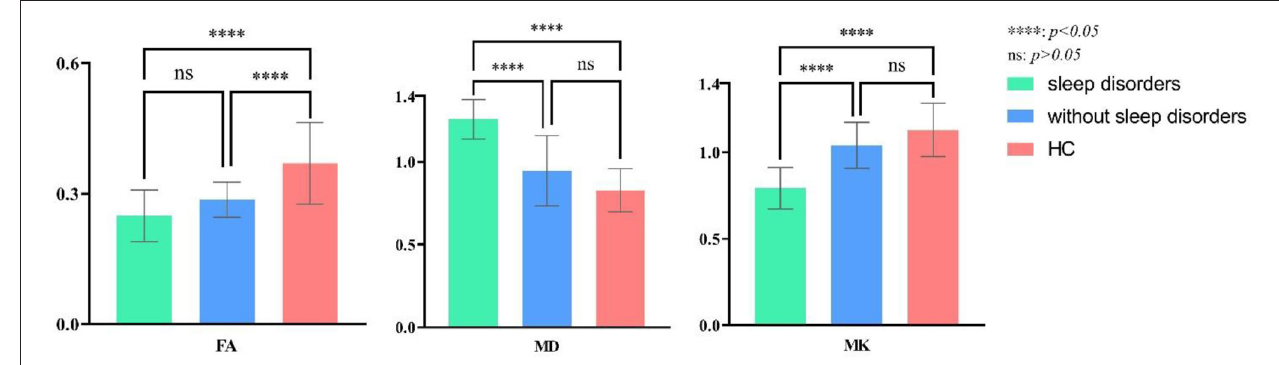
FIGURE 5 | Post-hoc multiple comparison in DKI parameters of R-TLE with or without sleep disorders and the healthy